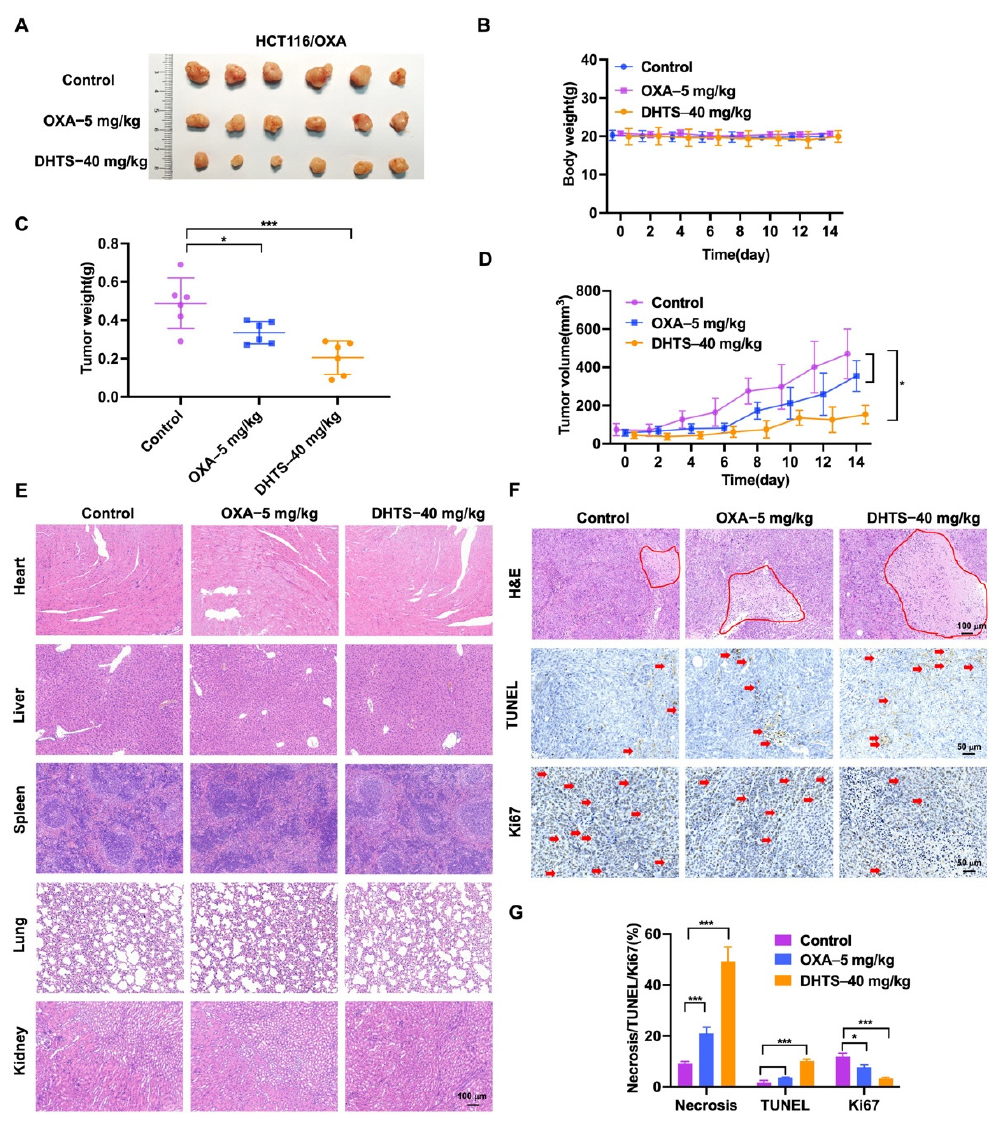
Figure 7. DHTS inhibits tumor growth in OXA-resistant HCT116 CRC mice model. ( A ) Tumor size in nude mice at the end of the study; ( B ) body weight growth curve of nude mice; ( C ) tumor weight in nude mice at the end of the study; ( D ) tumor growth curve in nude mice; ( E ) H&E staining of heart, liver, spleen, lung, and kidney in nude mice; ( F , G ) IHC staining and analysis of H&E, TUNEL, and Ki67 in mouse tumors (compared to the control group, * p < 0.05, *** p < 0.001). The red circle represents the area of necrosis in the tumor, and the red arrow indicates positive for Tunel and Ki67 staining.